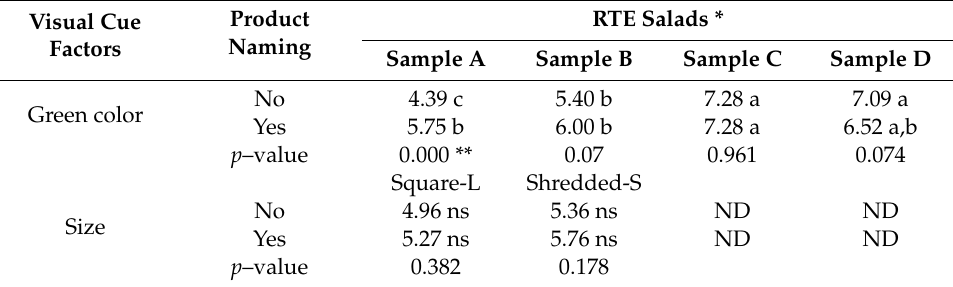
Table 4. Mean liking scores of green color and size of ready-to-eat (RTE) salads. Product RTE Salads * Visual Cue Naming Factors Sample A Sample B Sample C Sample D No 4.39 c Green color